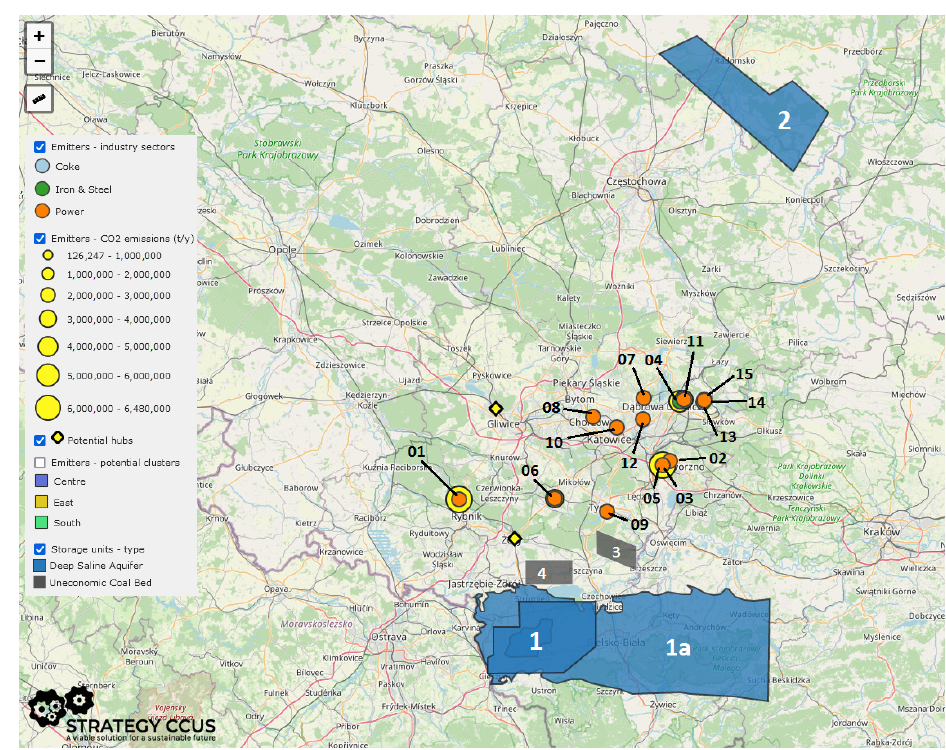
Figure 3. Locations of the largest CO 2 emitters and storage sites in Upper Silesia (based on: https://www.strategyccus.eu/sites/default/files/Upper_Silesia/index.html#9/50.3795/19.6655 (accessed on 16 June 2022)). Table 2. General geological properties of selected CO 2 storage sites.